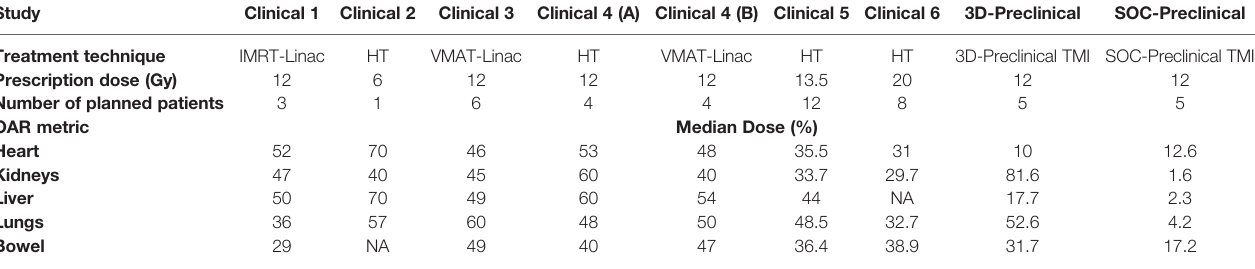
TABLE 2 | Dosimetric results of median dose in percent of the dose prescription of organs at risks for different clinical and preclinical TMI models. Study Treatment